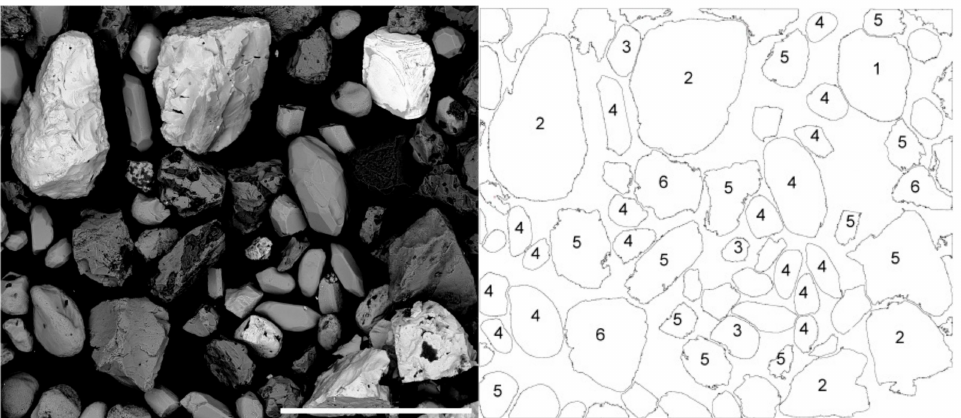
Figure 11. SEM electron backscatter image for a selection of sand grains from the Barrytown superheavy fraction with components identified from an EDS analysis of each individual grain. Key: 1 uraninite, 2 cassiterite, 3 monazite, 4 zircon, 5 ilmenite, 6 magnetite. Scale bar = 400 µ